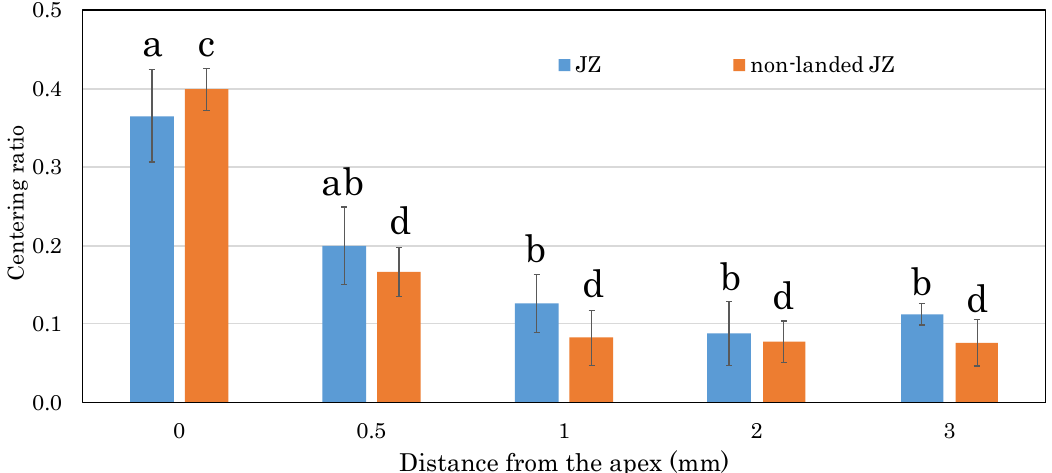
Figure 3. Canal-centering ratio at 0, 0.5, 1, 2, and 3 mm from the apex. Data represent the mean and standard deviation ( n = 10). JZ and the non-landed JZ are not significantly different at each measuring point ( p > 0.05). Different lowercase letters indicate the centering ratio values are significantly different within the same instrument ( p < 0.05).